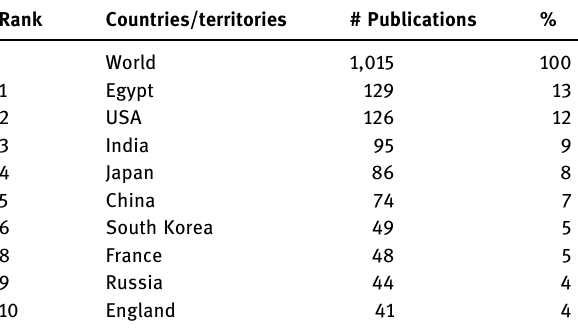
Table 1: Top ten of the countries publishing in the ionizing irra - diated polymer research fi eld ( 1975 – 2019 )